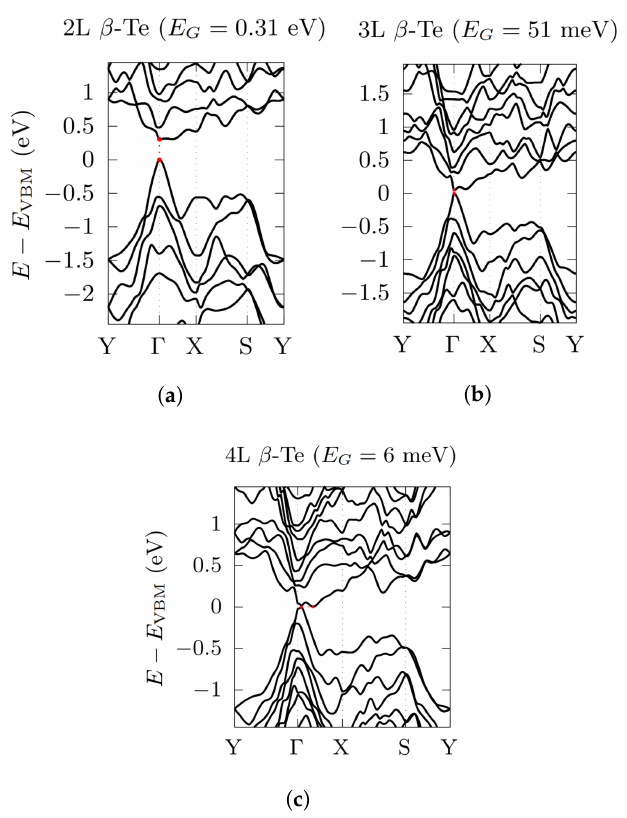
Figure 4. Electronic bandstructures, obtained by using a PBE functional, with the inclusion of SOC, for 2L β -Te ( a ), 3L β -Te ( b ) and 4L β -Te ( c ). Energy rescaled with respect to the VBM. High-symmetry points related to Figure 3 (orthorhombic